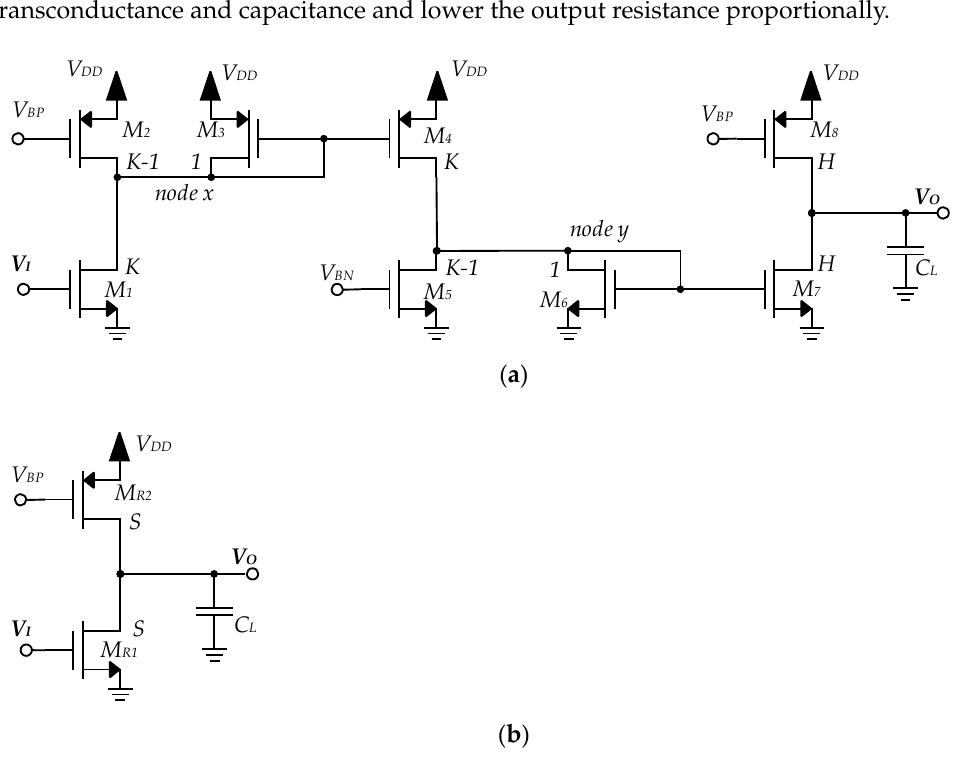
Figure 1. ( a ) Simplified topology of the amplifier, ( b ) conventional common-source amplifier.